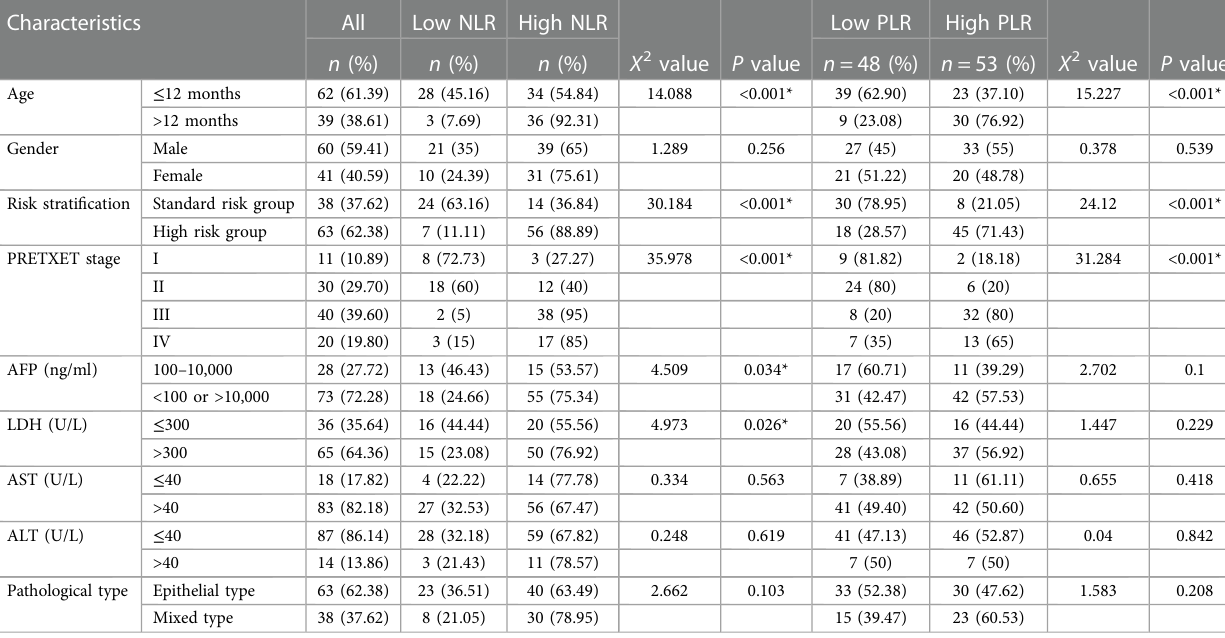
TABLE 3 Association of the patients ’ characteristics with the platelet-to-lymphocyte and neutrophil-to-lymphocyte ratios.